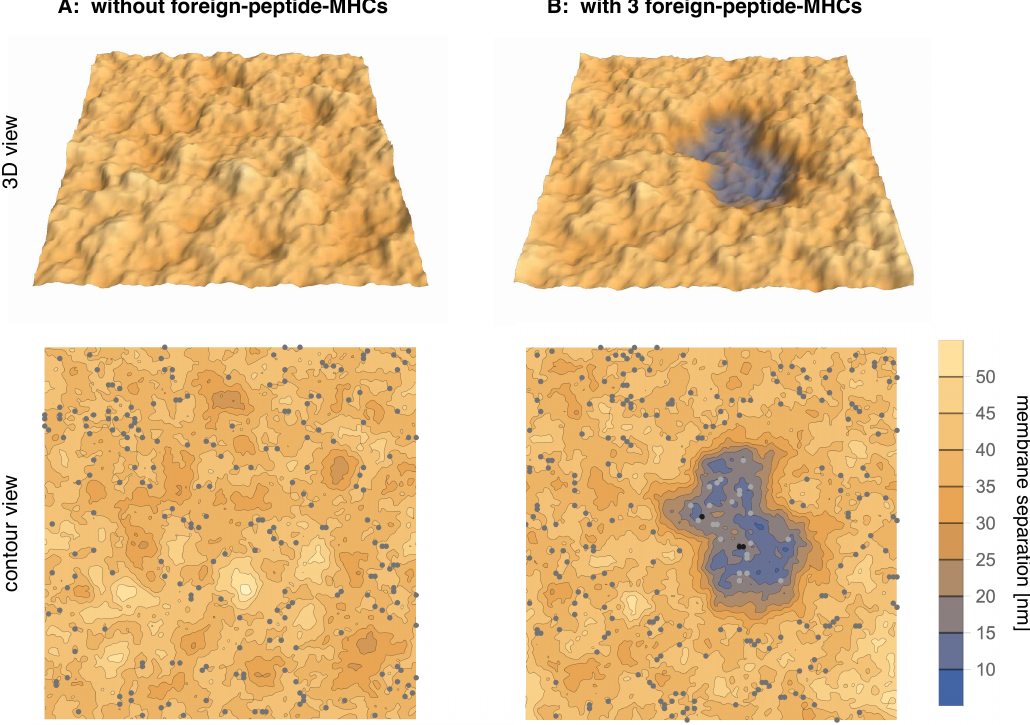
Figure 1. Simulation conformations of adhering membrane segments with area 1.5 × 1.5 µ m 2 ( A ) in the absence of foreign- peptide-MHCs and ( B ) in the presence of three foreign-peptide MHCs with binding energy U f = 12 k B T to TCRs. In ( A ), the binding energy U s = 5.9 k B T of the 270 self-peptide-MHCs is not sufficient to stabilize a close-contact zone of the adhering membranes. The adhesion is therefore mediated by LFA-1/ICAM-1 complexes (grey dots) with a concentration of about 100/ µ m 2 . The close-contact zone in ( B ) is cooperatively stabilized by 3 TCR/foreign-petide-MHC complexes (black dots) and many TCR/self-peptide-MHC complexes (light grey